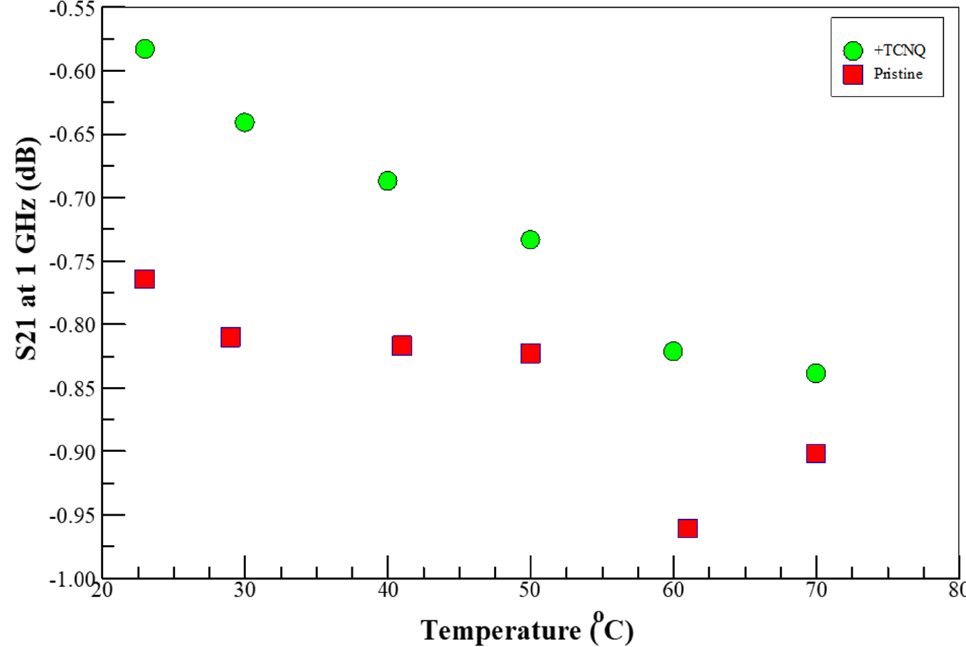
Figure 3. Temperature dependence of microwave insertion loss amplitude (S 21 ) of pristine and TCNQ-doped HKUST-1 SURMOF on Si in a N 2 -rich air environments, at 1 GHz. The error bars represent the standard deviation of at least three measurements on the same sample and are substantially smaller than the symbol sizes.